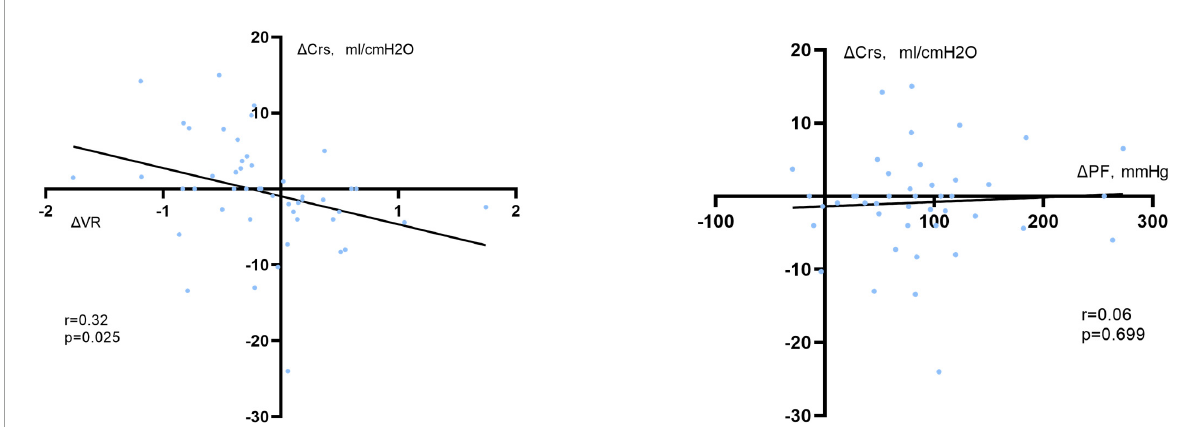
FIGURE4 Correlation between changes in the static compliance of the respiratory system ( (cid:49) Crs) and changes in VR at time P1 ( (cid:49) VR, left ) or PaO 2 :FiO 2 ratio at time S1 ( (cid:49) PF, right ) when compared with the supine position. VR was calculated as a ratio which compares actual measurements and predicted values of minute ventilation and PaCO 2 as proposed previously. Crs was calculated as Vt divided by driving pressure. And driving pressure was acquired during an end-inspiration and end-expiration maneuver, calculated as plateau pressure minus end-expiratory